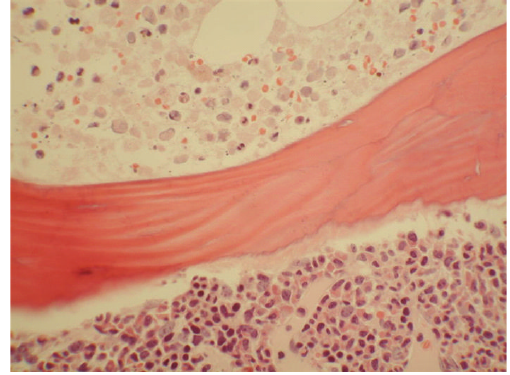
Figure 2: Low power photomicrograph of bone marrow showing areas of necrosis and nonnecrotic areas after G-CSF administration.